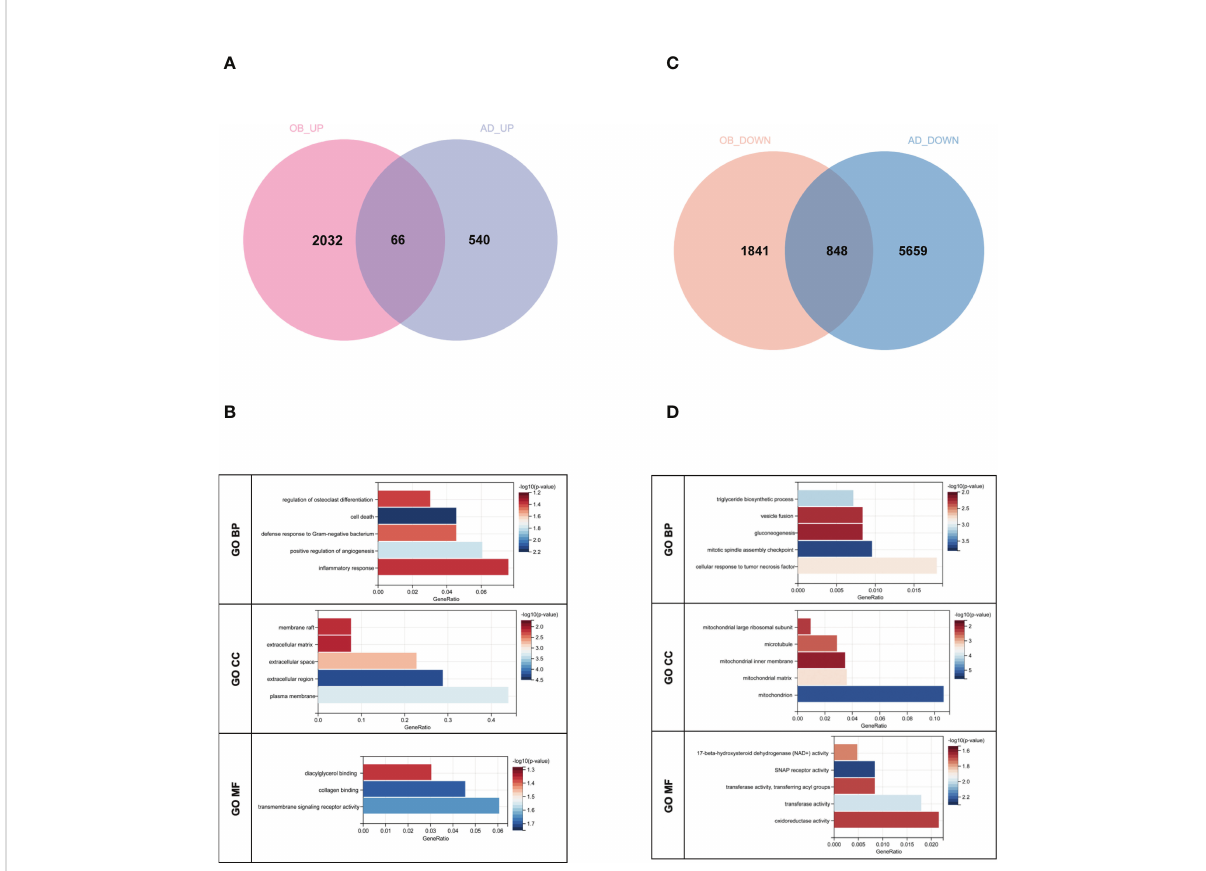
FIGURE 3 Venn diagram and GO enrichment analysis. (A) The shared genes between positive OB related and AD related modules. (B) GO analysis of shared genes between positive OB related and AD related modules. (C) The shared genes between negative OB related and AD related modules. (D) GO analysis of shared genes between negative OB related and AD related modules. OB, obesity; AD, Alzheimer ’ s